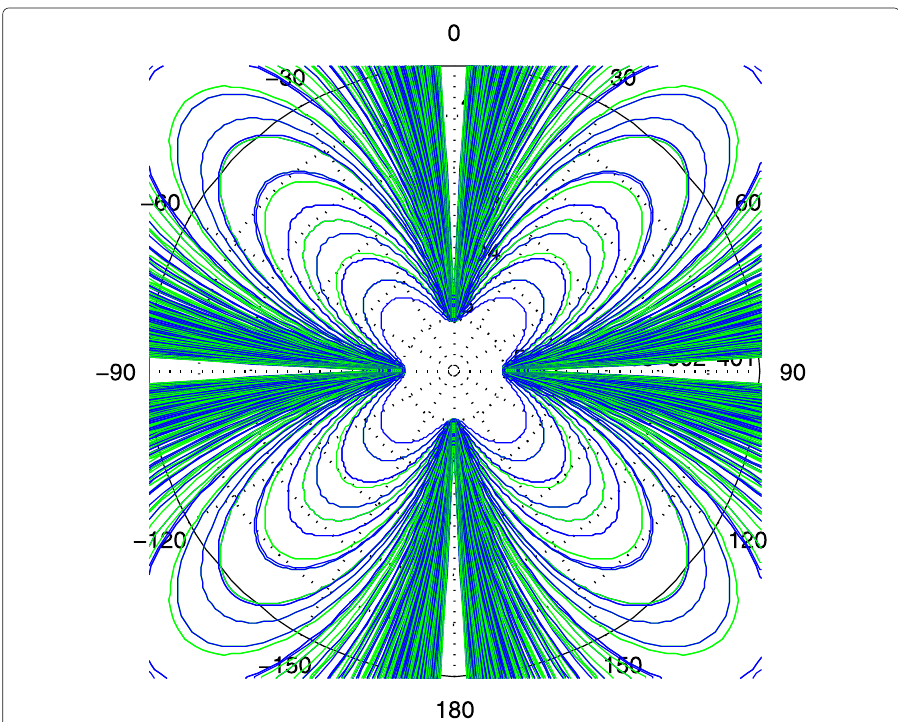
Fig. 7 FIM of phase estimation as a function of the number of antenna elements in the